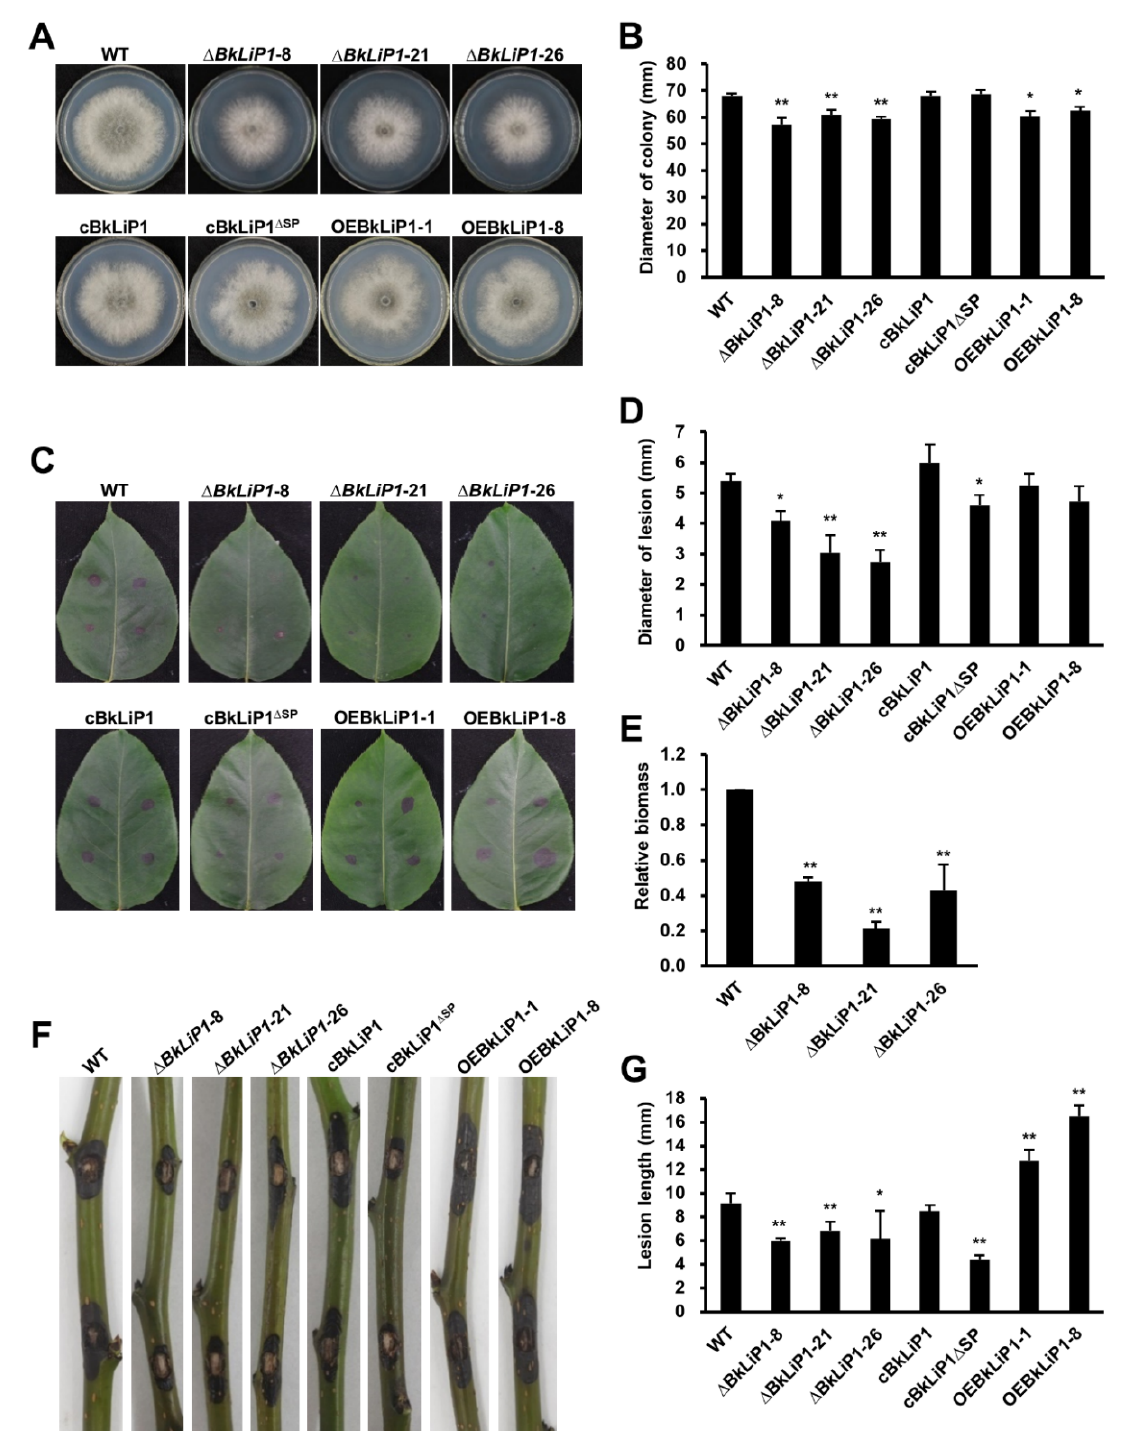
Figure 2. Growth assessment and virulence test of B. kuwatsukai and its derivative strains by knock-out or recovery of BkLiP1 . ( A , B ) Morphologies and colony diameters as grown on PDA for 3 days at 28 °C for wild-type strain SZ2l62 (WT), the BkLiP1 deletion mutants ( ∆ BkLiP1 -8, ∆ BkLiP1 -21, and ∆ BkLiP1 -26), the BkLiP1 complemented transformants (cBkLiP1 and cBkLiP1 ∆ SP ), and the BkLiP1 overexpression strains (OEBkLiP1-1 and OEBkLiP1-8). ( C , D ) Representative symptoms and lesion sizes on the detached pear ( P. pyrifolia cv. Hohsui) leaves at 4 dpi induced by BkLiP1 deletion mu- tants, complemented transformants, and overexpression strains. ( E ) Relative biomass of B. ku- watsukai in infected pear ( P. pyrifolia cv. Hohsui) leaves at 4 dpi determined by qPCR. ( F , G ) Repre- sentative symptoms and lesion sizes on the detached pear ( P. pyrifolia cv. Hohsui) shoots at 3 dpi induced by BkLiP1 deletion mutants, complemented transformants, and overexpression strains. Vir- ulence was evaluated based on lesion length. Mean and standard deviation were estimated with data of more than three (n > 3) independent biological replicates. Bars indicate ± SE. Asterisks at the top of the bars indicate statistical significance (* p < 0.05; ** p < 0.01).